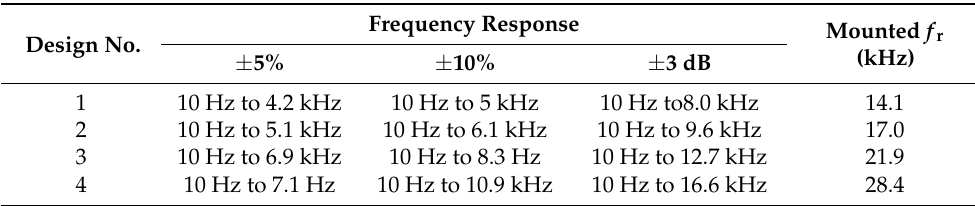
Table 4. Frequency response properties of the accelerometer prototypes obtained from vibration experiments.